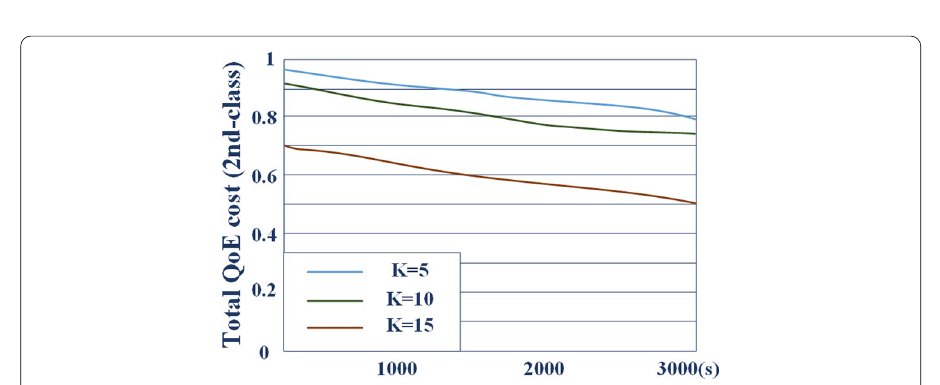
Fig. 14 QoE (c2) under different flow